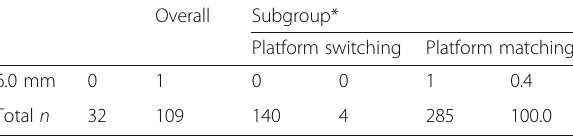
Table 3 Patient demographics with respect to implants Overall